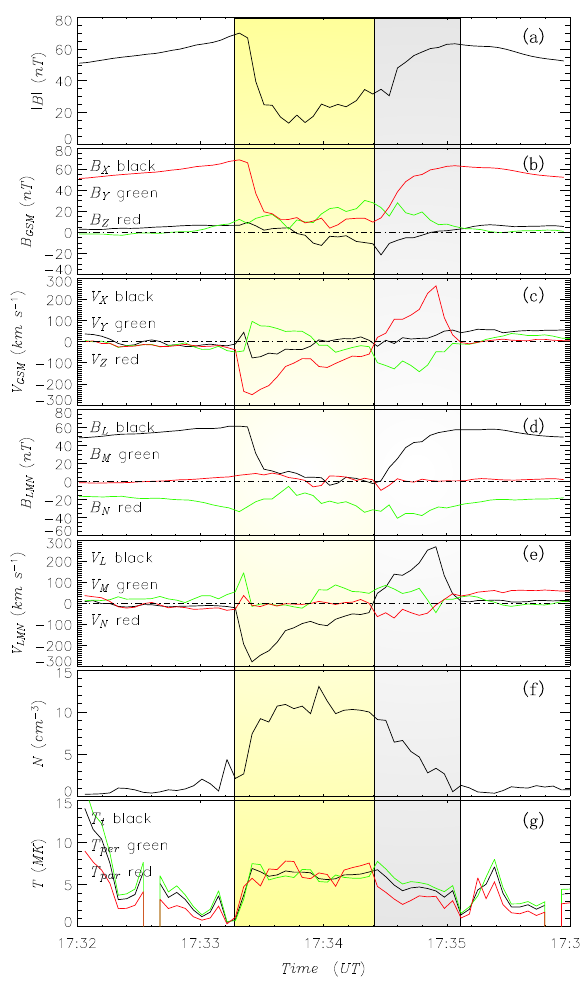
Fig. 3. TC-1 measurement during a brief encounter of the magne- topause on 12 March 2004 (details are in the